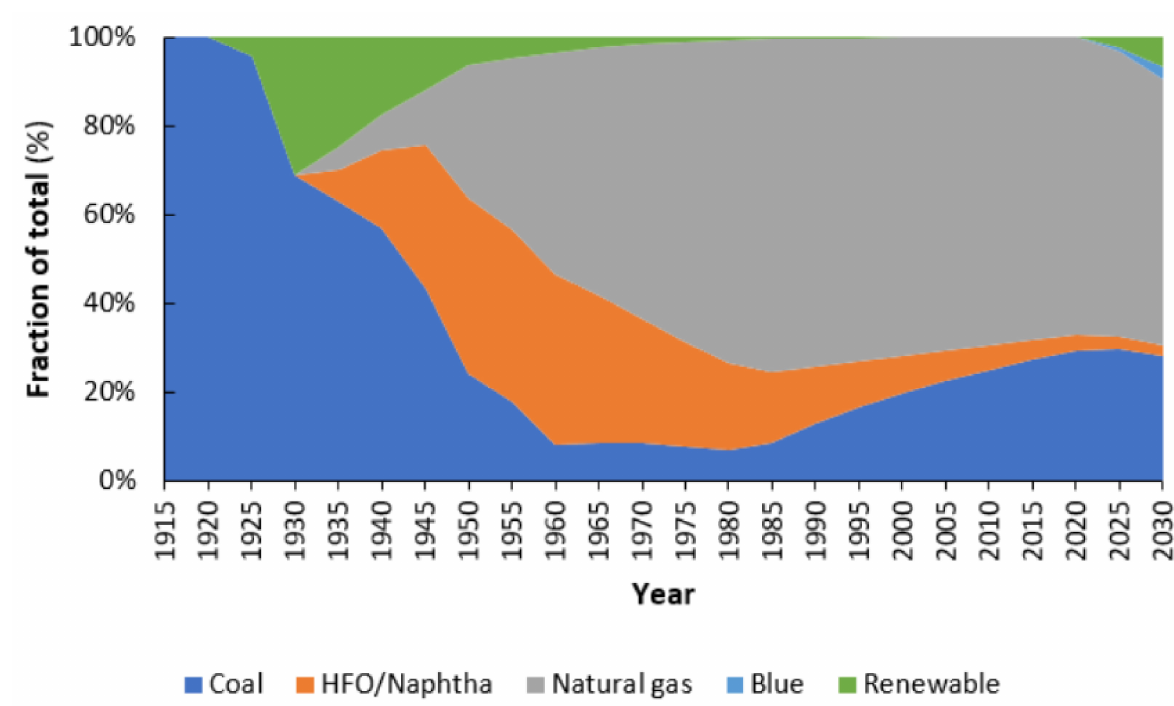
Figure 1. Historical ammonia production by feedstock, and expected production until 2030. Coal: coal gasification; HFO: heavy fuel oil gasification; Naphtha: naphtha reforming; Natural gas: steam methane reforming; Blue: steam methane reforming with carbon capture and storage (CCS); Renew- able: electrolysis. The original data can be found in the Supplementary Materials